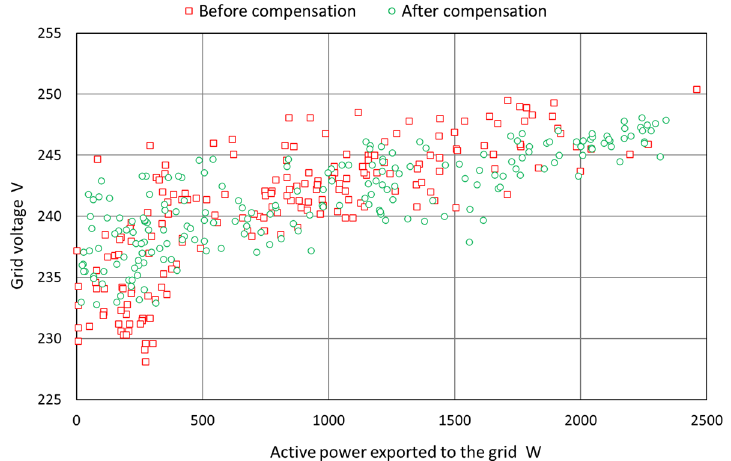
Figure 14. Voltage at energy export before and after capacitive reactive power compensation. Nowadays, all inverters have the option to set a fixed power factor value from − 0.8 (cap.) to 0.8 (ind.). There are also inverters in which the power factor may vary (according to the segmental approximation) depending on the amount of generated